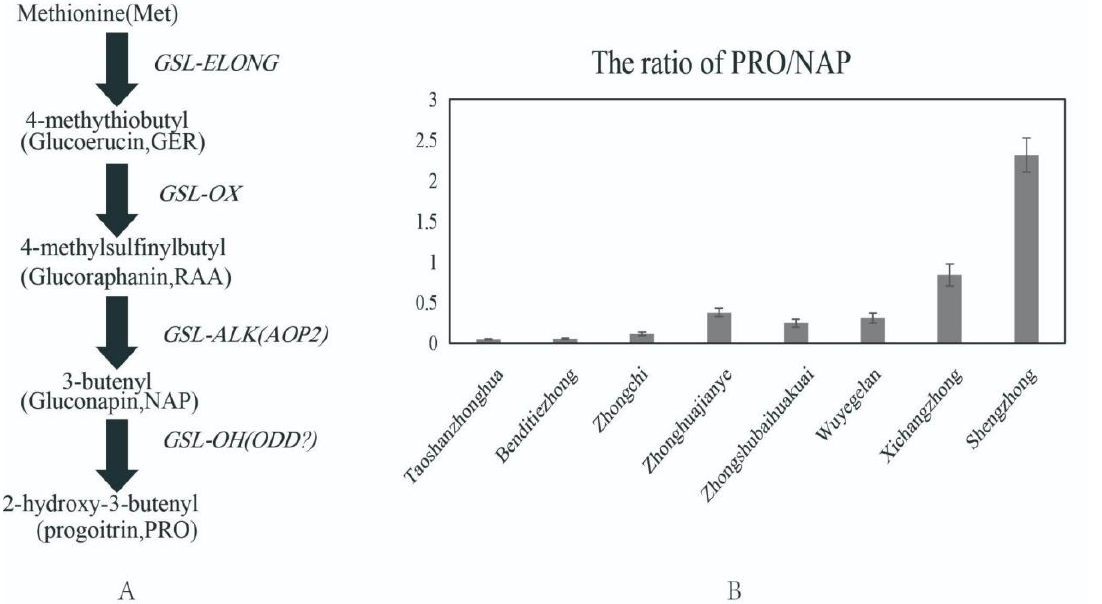
Figure 1. The conversion of NAP to PRO glucosinolate. ( A ) The side chain of aliphatic glucosinolate biosynthesis; ( B ) the ratio of PRO/NAP in different Chinese kale genotypes.